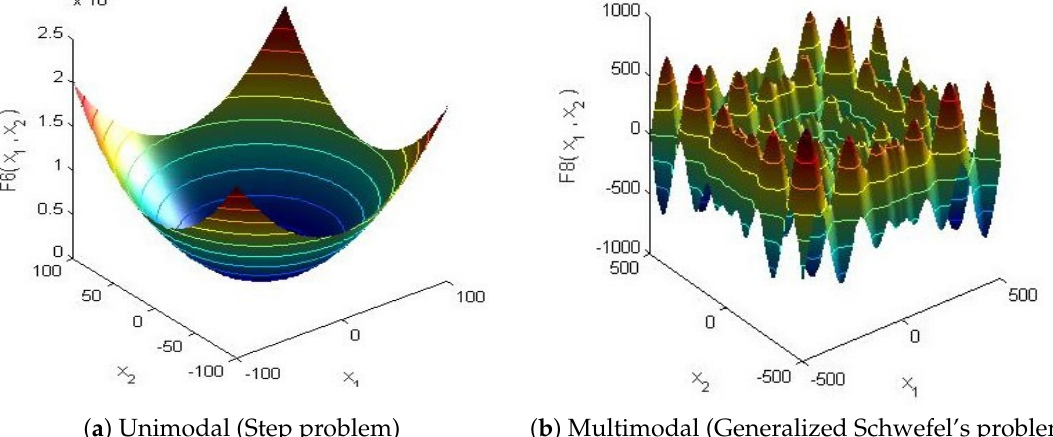
Figure 2. 3D search space for optimization